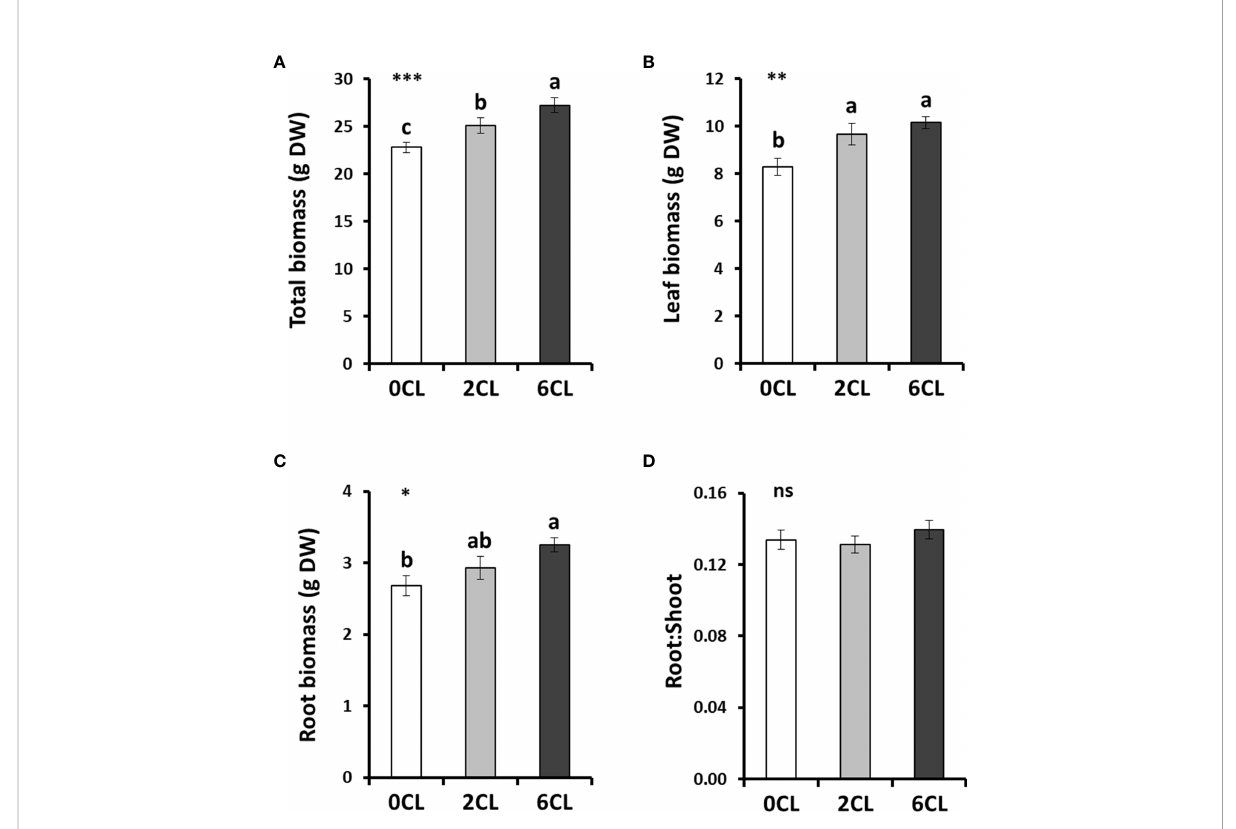
FIGURE 1 Effect of Cl − nutrition on plant growth. Tobacco plants were treated with 0, 2 and 6 mM of Cl − salts (CL), and supplemented with a mix of sulphate+phosphate salts to maintain a similar cationic balance. (A) Total dry weight (DW); (B) total leaf DW; (C) total root DW; and (D) root: shoot ratio are shown. Mean values ± SE, n =12. Statistics was calculated through ANOVA, where mean values with different letters are signi fi cantly different according to Tukey ’ s test at P ≤ 0.05. Levels of signi fi cance: * P ≤ 0.05; ** P ≤ 0.01; *** P ≤ 0.001; and ‘ ns ’ P >